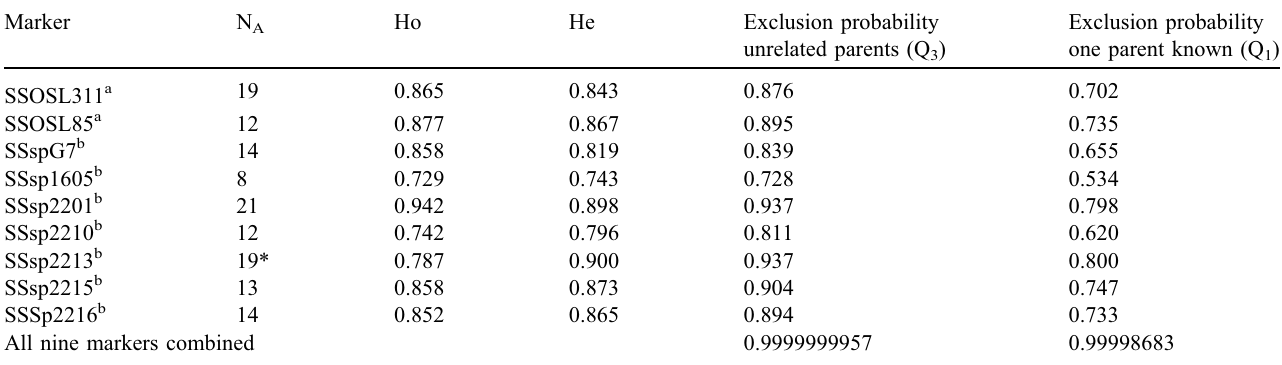
Table 2. Variability and assignment power of the nine microsatellite markers estimated from the F0 salmon broodstock present in Bergerac hatchery from 2010 to 2014 (156